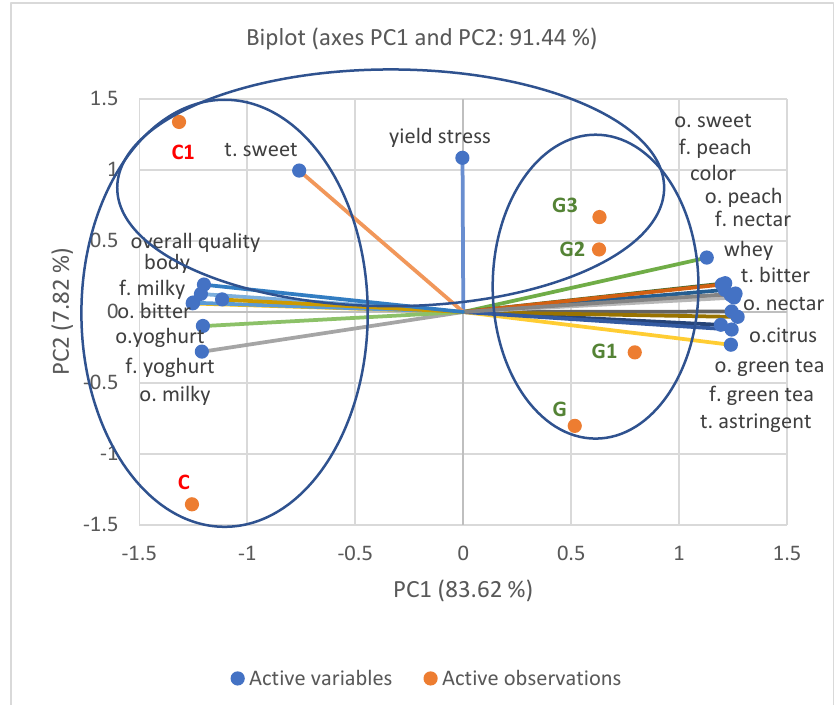
Figure 5. Principal Component Analysis (PCA) of the yoghurt samples: C, C1, G, G1, G2, G3. The abbreviations in the figure refer to the control sample (C), control yoghurt with 6% inulin (C1), yoghurt with green tea (G), yoghurt with green tea and 3% inulin (G1), yoghurt with green tea and 6% inulin (G2), yoghurt with green tea and 9% inulin (G3) (o—odor, t—taste, f—flavor). Attributes that significantly statistically differentiated the samples are on PCA ( p ≤ 0.05).